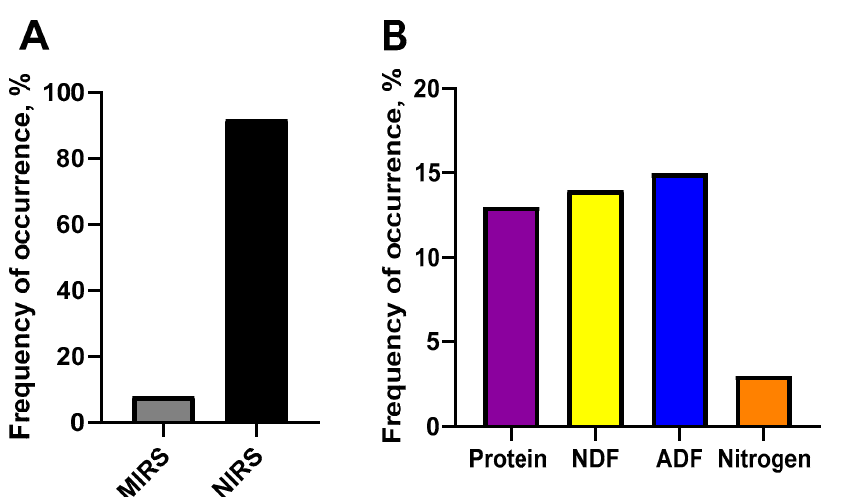
Figure 3. Comparison of the main characteristics of feed analyzers: ( A ) Distribution of devices according to the used frequency range. ( B ) Distribution of devices according to the analyzed characteristics.